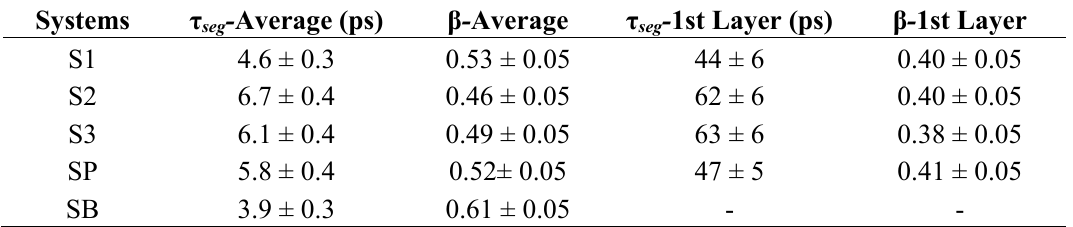
Figure 7. ( a ) Segmental relaxation time, τ seg , of v 1−3 characteristic vector based on P 2 ( t ) time autocorrelation as a function of R (distance from the center of the graphene layer) for the S2 system; ( b ) The stretch exponent β, as extracted from the fit with KWW functions. Dashed lines represent τ seg and β values of bulk PE under similar conditions ( T = 450 K, P = 1 atm). Table 3. Average segmental relaxation times τ seg and stretch exponents β of PE chains for all systems studied here (columns 2 and 3). τ seg values and stretch exponents β for all systems in the first adsorption layer are shown in columns 4 and 5. Error bars are obtained using block averaging